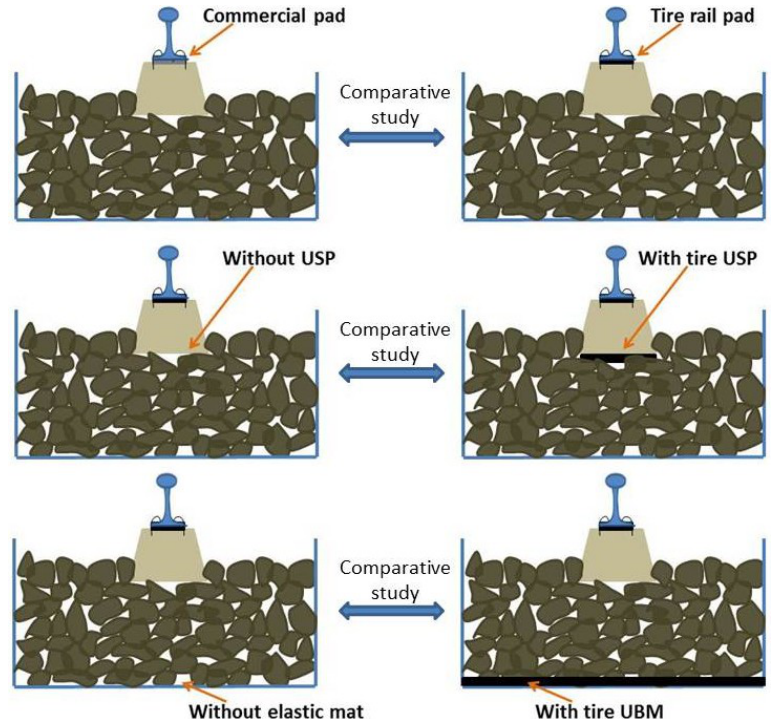
Figure 2. Comparative study of the effect of different elastic